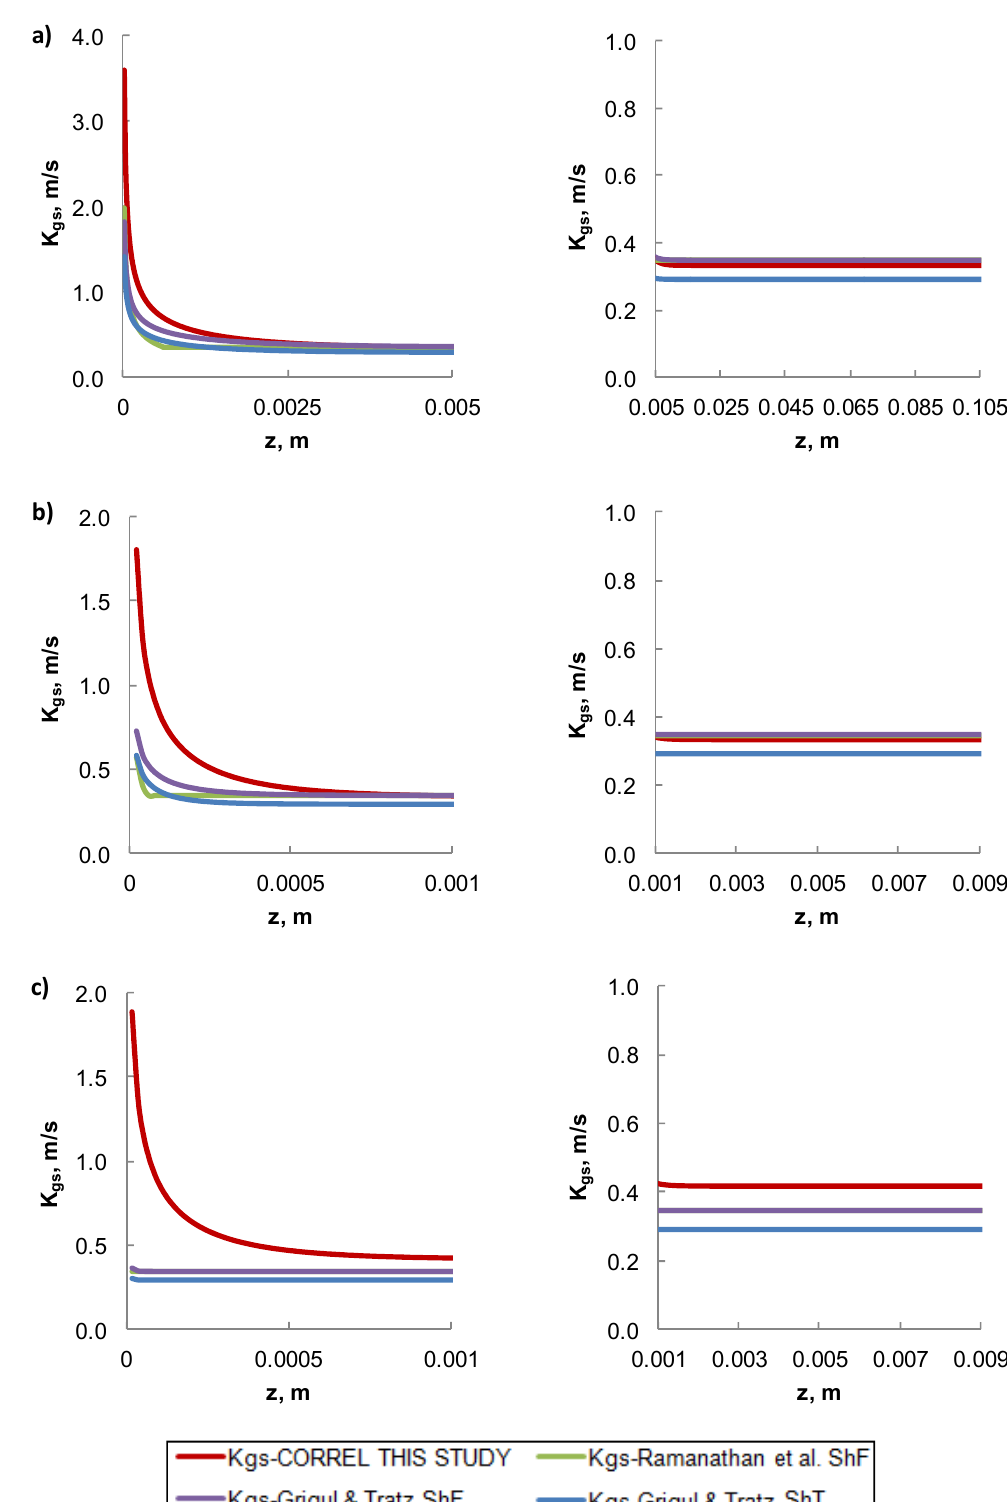
Figure 5. Comparison of the mass transfer correlation for monoliths published in the literature by Ramanathan et al. [12] and Grigul and Tratz [22] with the one proposed in this paper. Diagrams of mass transfer coefficient along the cell length for CO species at temperature 400 °C. Cell diameter d = 1.1 mm. ( a ) Velocity u = 6.27 m / s. Re = 109, ( b ) Velocity u = 0.521 m / s. Re = 9, ( c ) Velocity u = 0.033 m / s. Re =